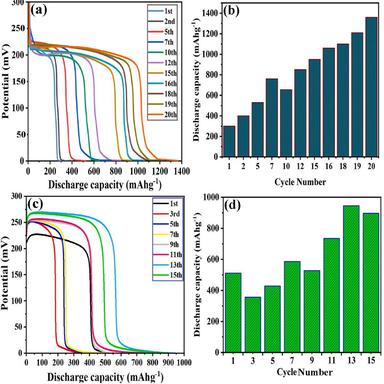
Discharge profiles and cycles discharge capacity profiles of (a, b): S1 and (c, d): S3.